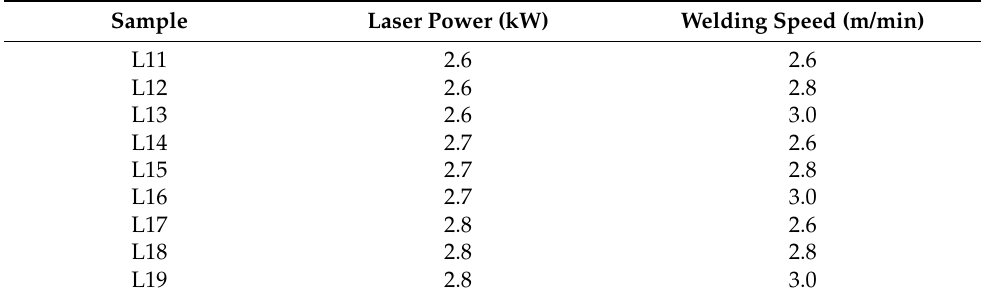
Table 2. Experimental Process